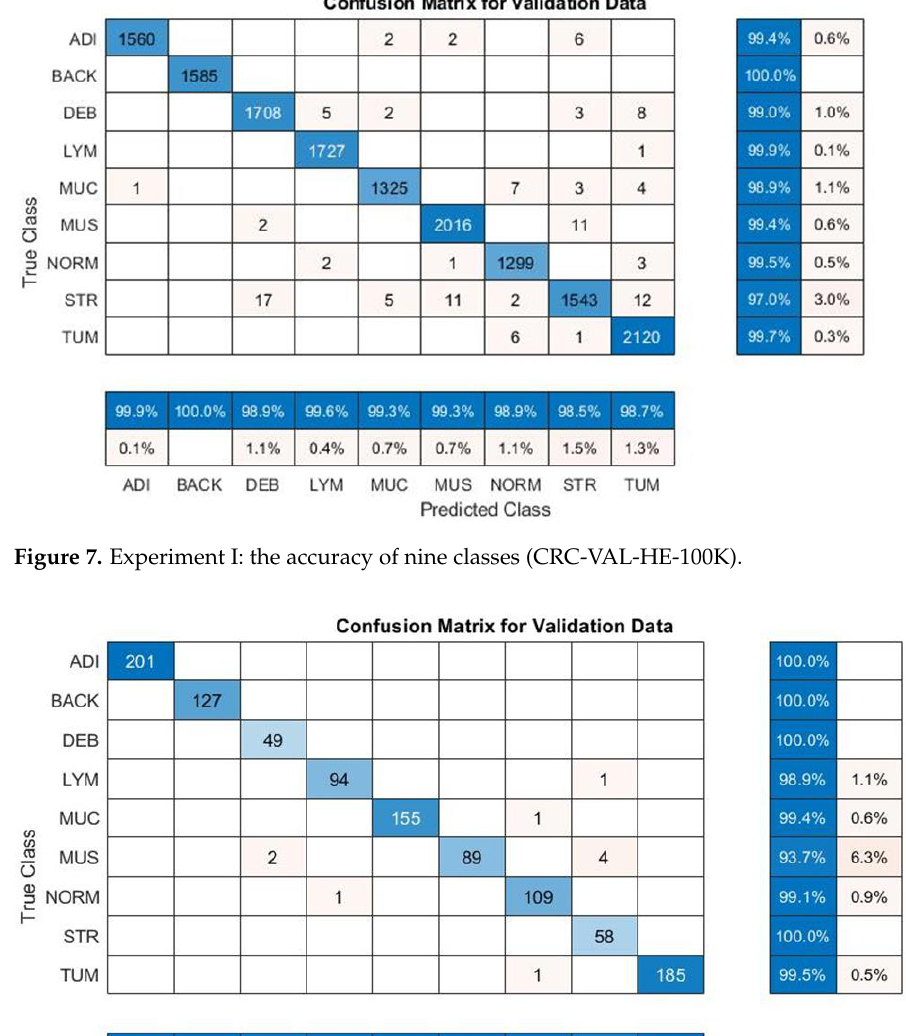
Table 5. Experiment I: the best results of nine tissue classes (CRC-VAL-HE-7K).